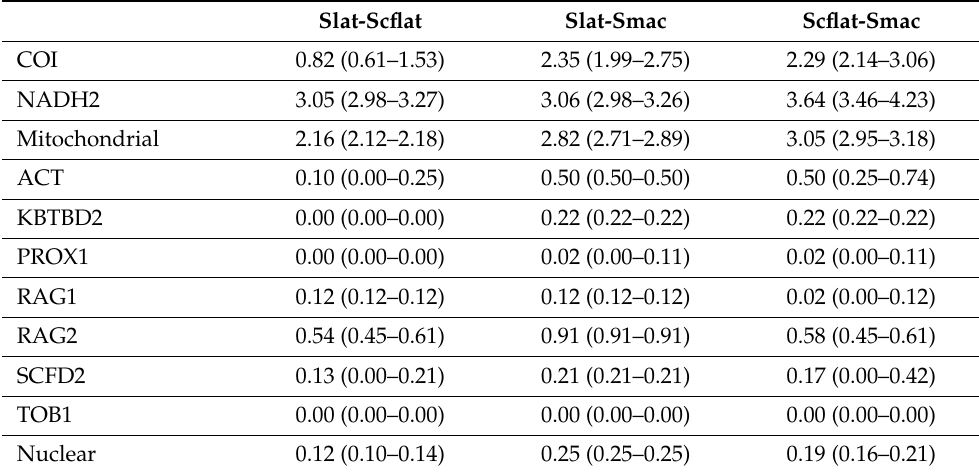
Table 3. Genetic distance range (mean, in percent) among monophyletic groups in mitochondrial DNA and nuclear DNA phylogenetic trees. Slat— Scoliodon laticaudus , Scflat— S . cf. laticaudus , and Smac— S. macrorhynchos .